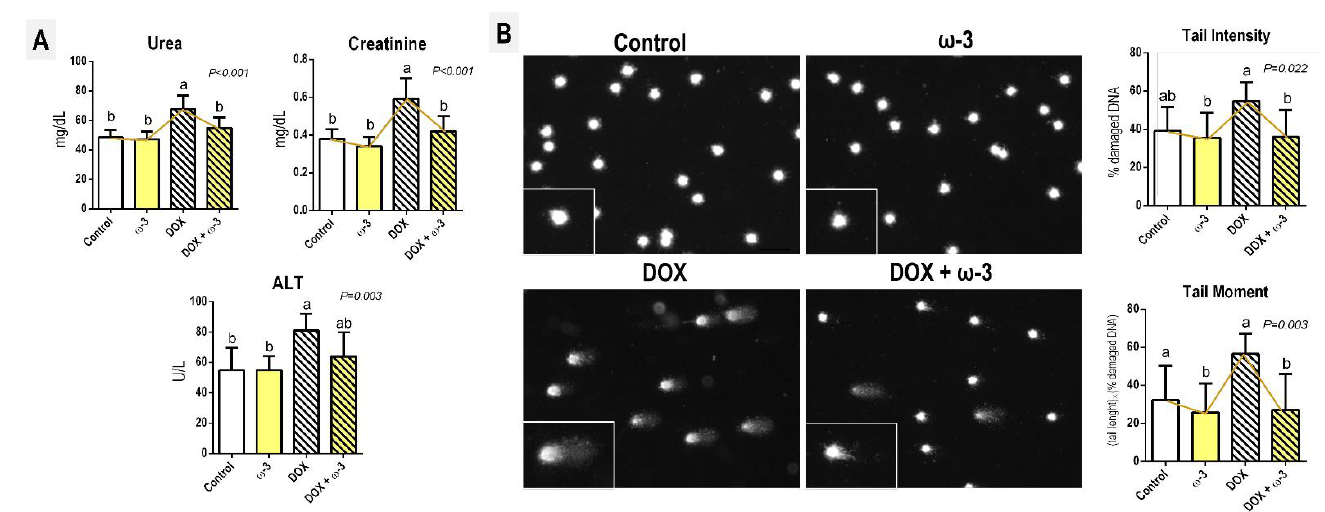
animals received weekly single intraperitoneal injections of DOX (3.5 mg/kg body weight) for four weeks (or vehicle). The letters correspond to the statistical difference among groups by one-way ANOVA followed by a posteriori Tukey test ( p < 0.05).